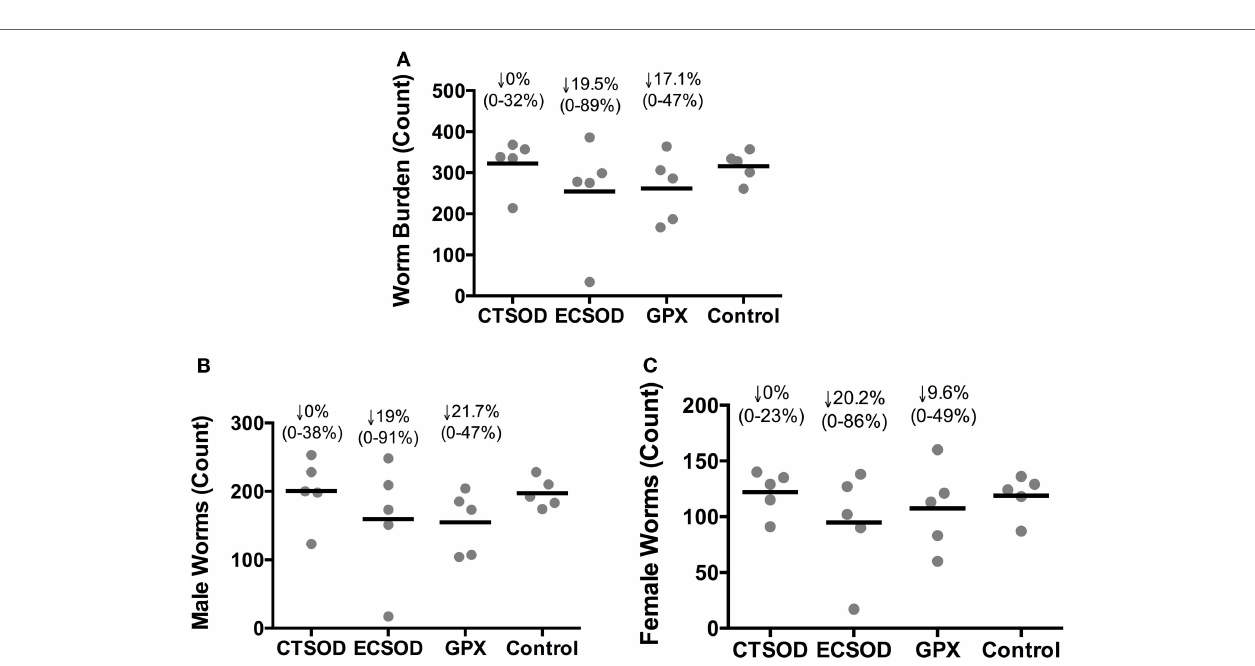
percentage of reduction (represented by the arrow), the range (minimal– maximal, represented between brackets), and the statistical p -value were expressed in comparison to the mean average of the Control group. Non- parametric (Kruskal–Wallis, Mann–Whitney) tests were applied. Values were considered statistically significant when p <